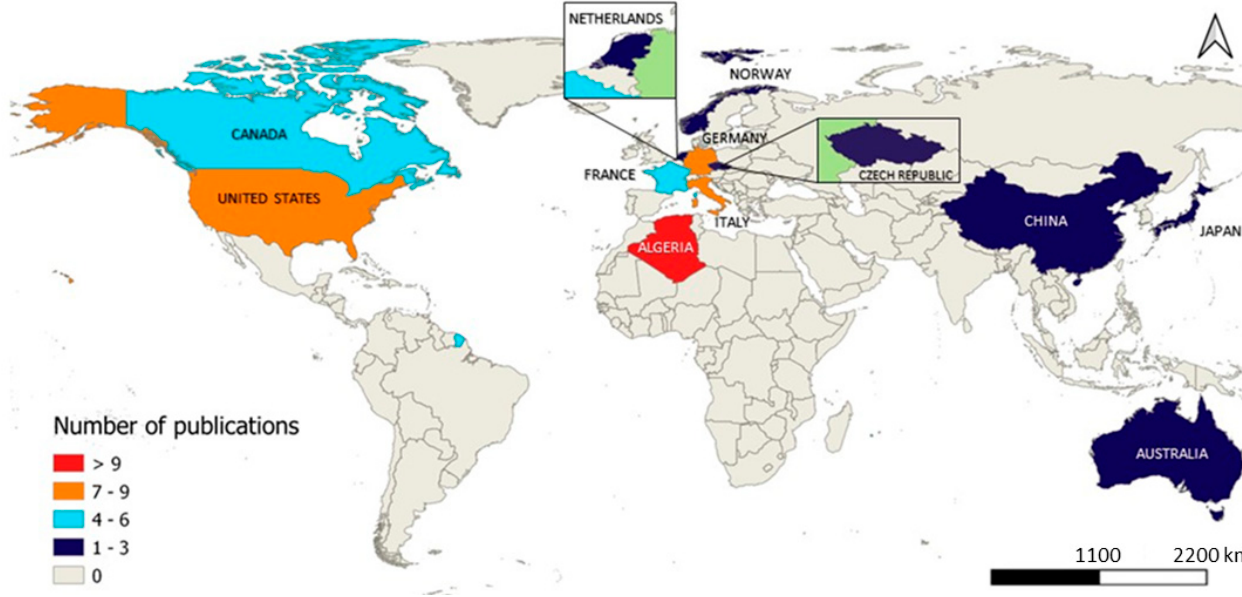
Figure 7. World spatial distribution of the scientific contributions.